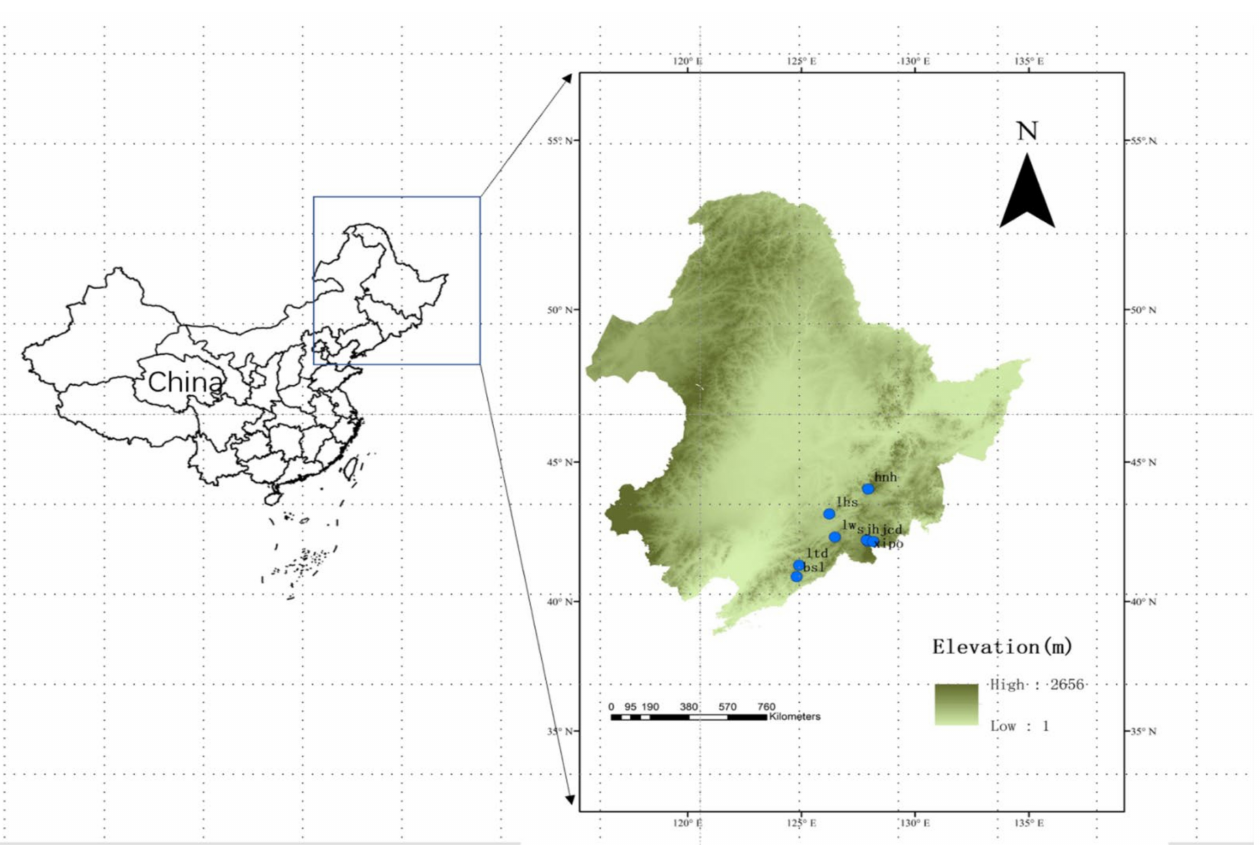
Figure 1. The study area and distribution of forest sites in northeastern China. Eight study sites include LianHuaShan (lhs), HuangNiHe (hnh), LongWan (lw), BaiShiLazi (bsl), LaoTuDing (ltd), SongJiangHe (sjh), XiPo (xipo), and JiaoCuoDai